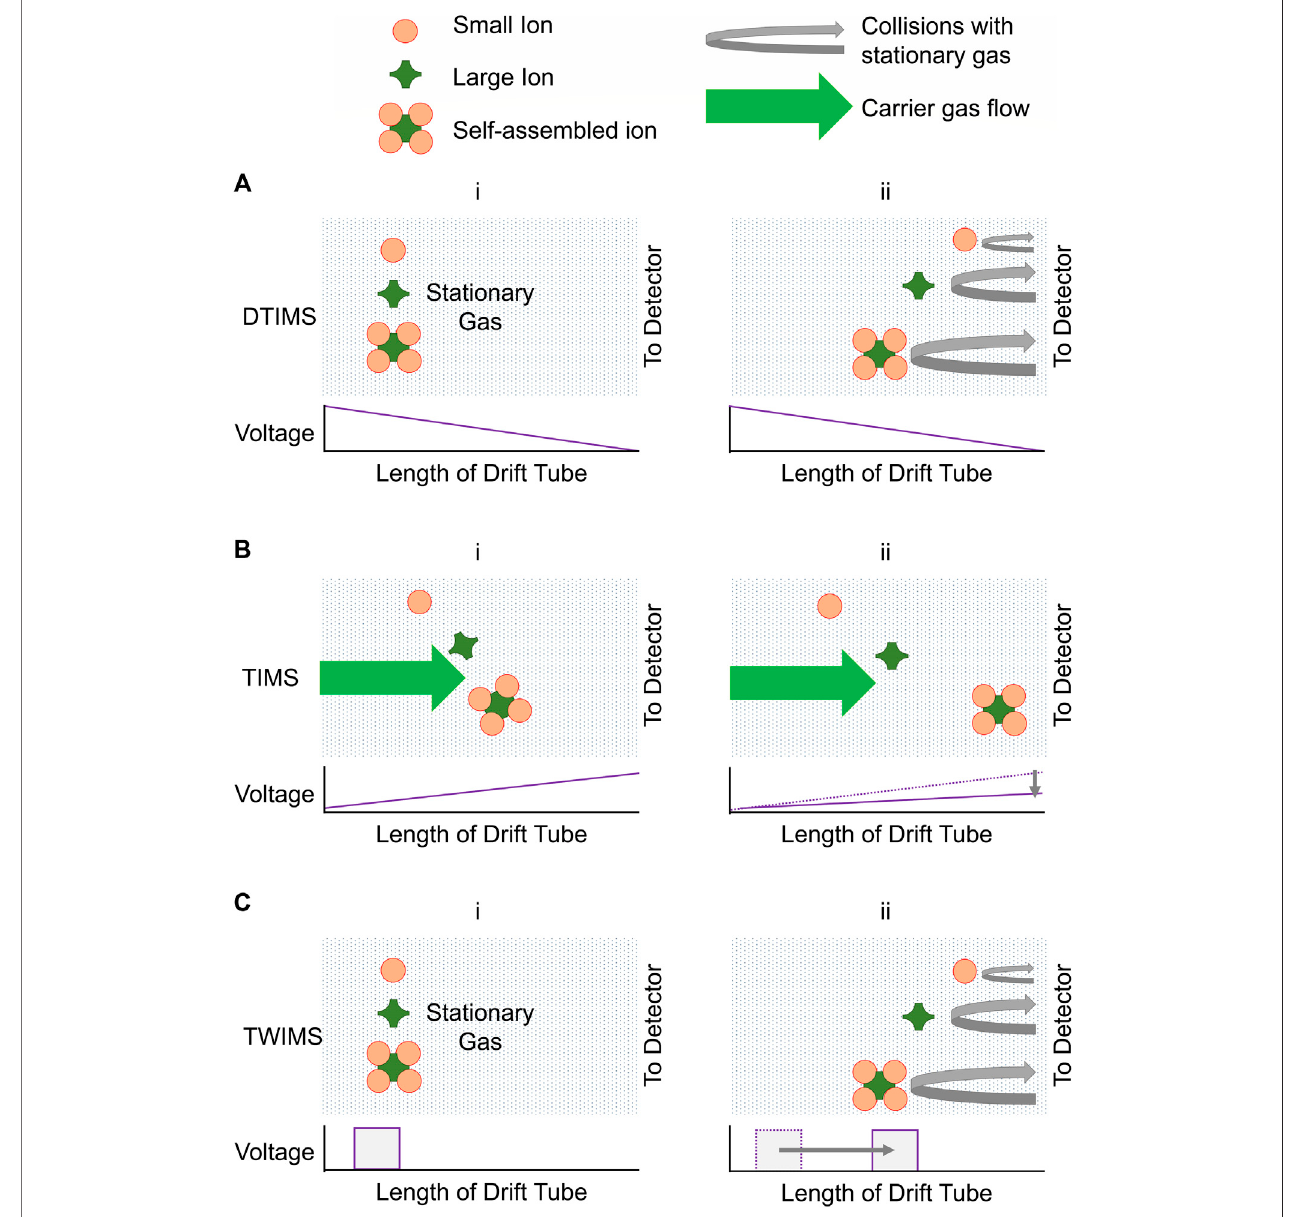
FIGURE4| Severalcommonionmobilityspectrometersthatresultinionsofdifferentsizes/topologiesbeingseparatedintime.Themodeofactionof: (A) DriftTube Ion Mobility Spectrometry (DTIMS), (i) accelerates swarms of ions with an electric fi eld and (ii) their kinetic energy is reduced by varying amounts by collision with stationary gas molecules; (B) Trapped Ion Mobility Spectrometry (TIMS), (i) separates swarms of relatively stationary ions through collision with moving drift gas and (ii) eluting the ions in turn by decreasing the trapping potential; (C) Travelling Wave Ion Mobility Spectrometry (TWIMS) (i) pushes swarms of ions against a stationary gas using travelling voltage waves to move the ions down the cell over time, some more ef fi ciently than others. (ii) the ions become distributed according to their topologies as they are carried along with various ef fi ciencies and kinetic energy is reduced by varying amounts by collision with stationary gas molecules.